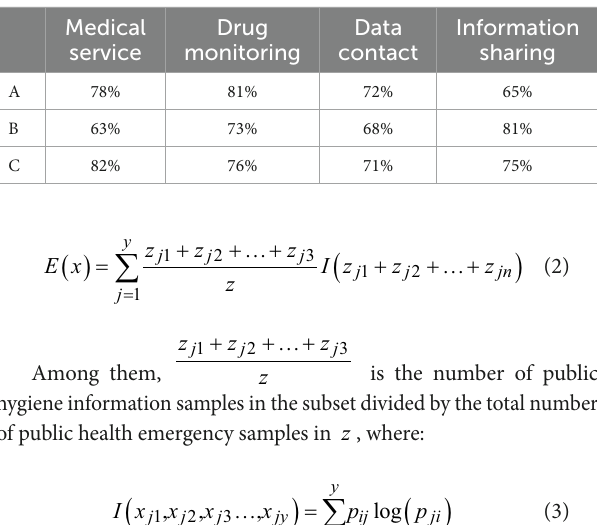
TABLE 1 The systematic and use of public health information in health records